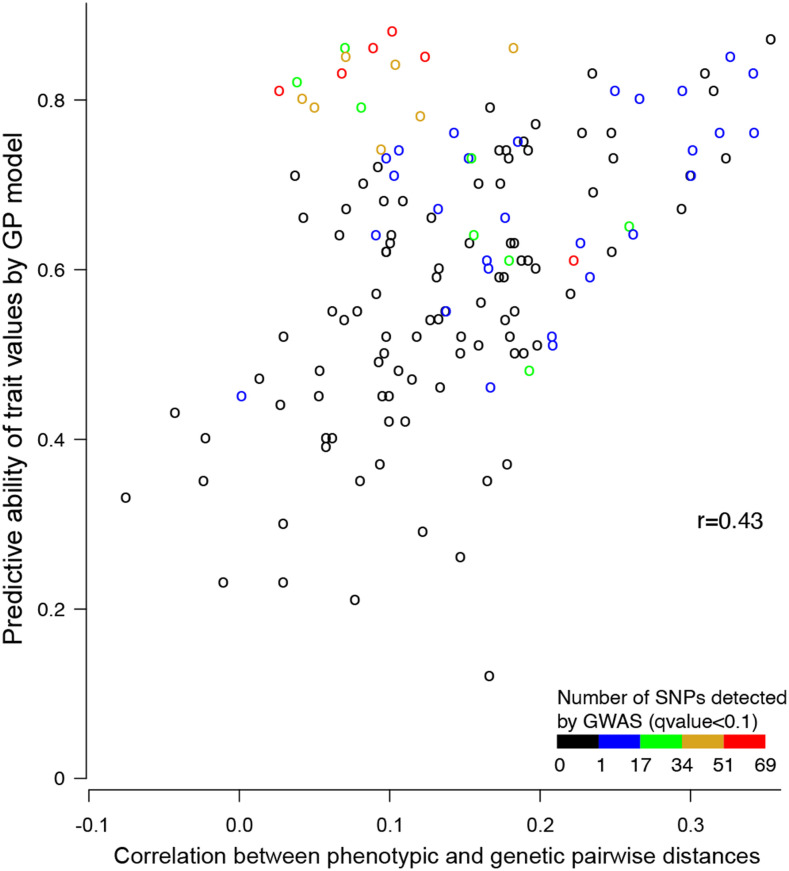
Scatterplot of the predictive ability of the genomic prediction model against the correlation between pairwise phenotypic and genetic Euclidian distances computed using all available SNP. Each dot represents a trait. The dots are colored according to the number of SNP markers detected as being significantly (considering a qvalue threshold of 0.1) linked to the trait according to a Genome Wide Association Study (GWAS). The value of the Pearson correlation between the two presented variables is given in the upper left corner. The genomic prediction models included all available SNP markers. To evaluate the predictive ability, 100 random calibration sets of all but 50 natural populations were used to predict the 50 remaining natural populations.